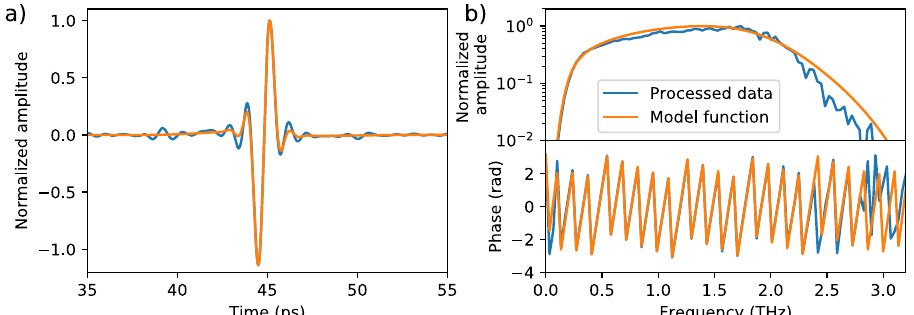
Fig. 7 Re fl ection measurement data and model of a 23 µ m PET foil. a Time-domain representation of the THz signal re fl ected from a single-layer PET foil with a nominal thickness of 23 µ m (blue) and corresponding model function (orange) used for thickness determination. Details on the model function can be found in the “ Methods ” section. b Spectral amplitude and phase of the measured data and model function. For these measurements, individual spectra were averaged ten times, which corresponds to an acquisition time of less than 0.2 s.